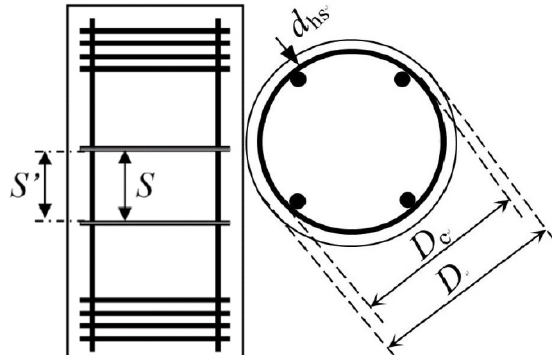
Figure 2. Parameters of λ hs for columns with internal steel